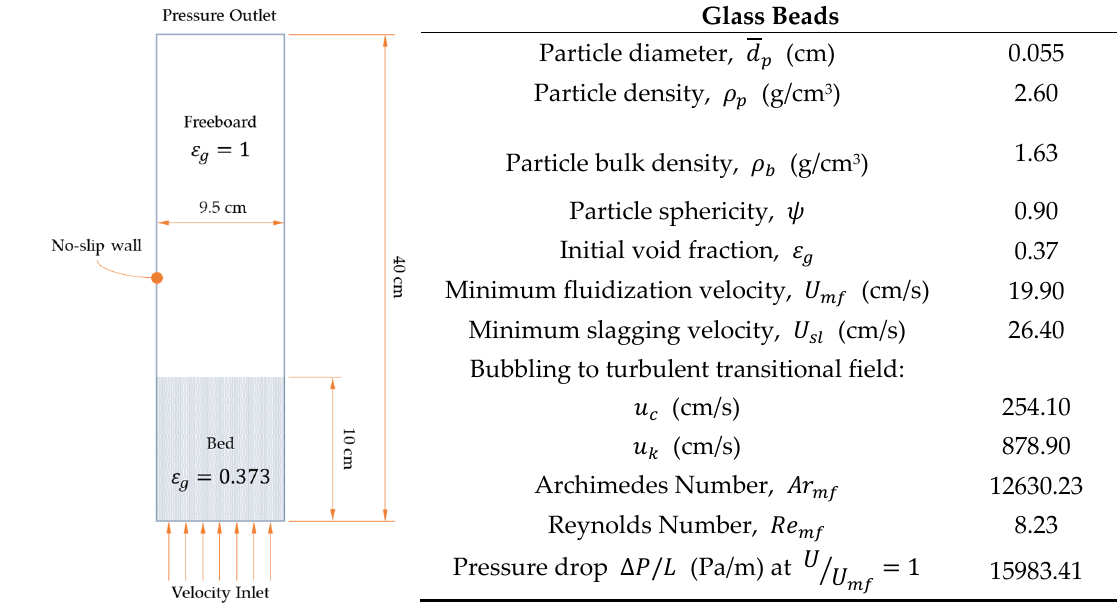
Figure 2. Schematic representation of the experimental apparatus used by Deza et al. [44], considered for the numerical validation of the mathematical model. In the table, characterizing properties of solid particles composing the inert bed material are collected.